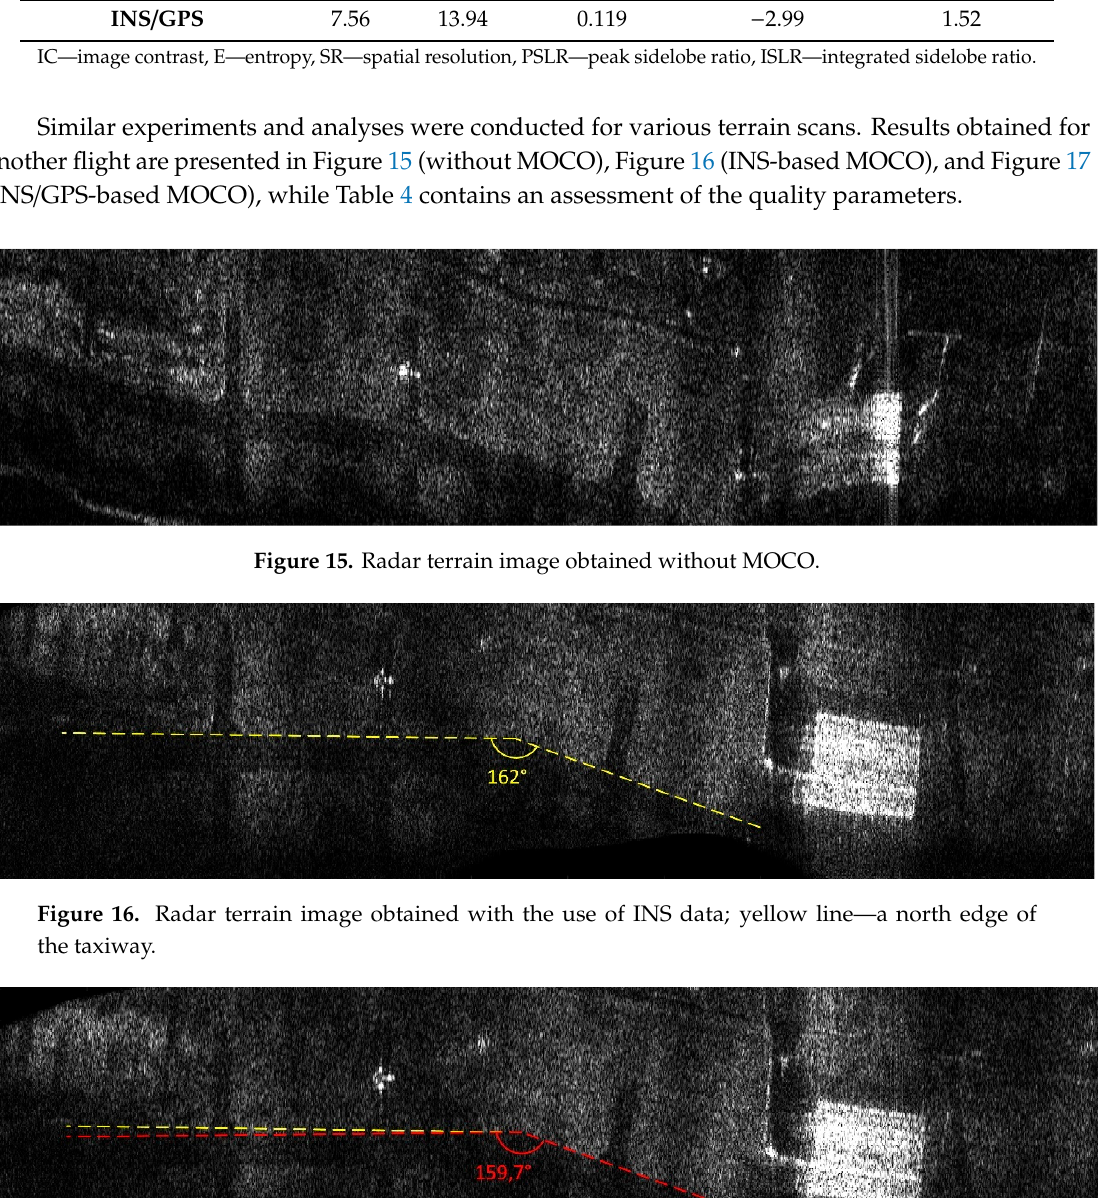
Table 3. Parameters of the quality of the selected SAR image.